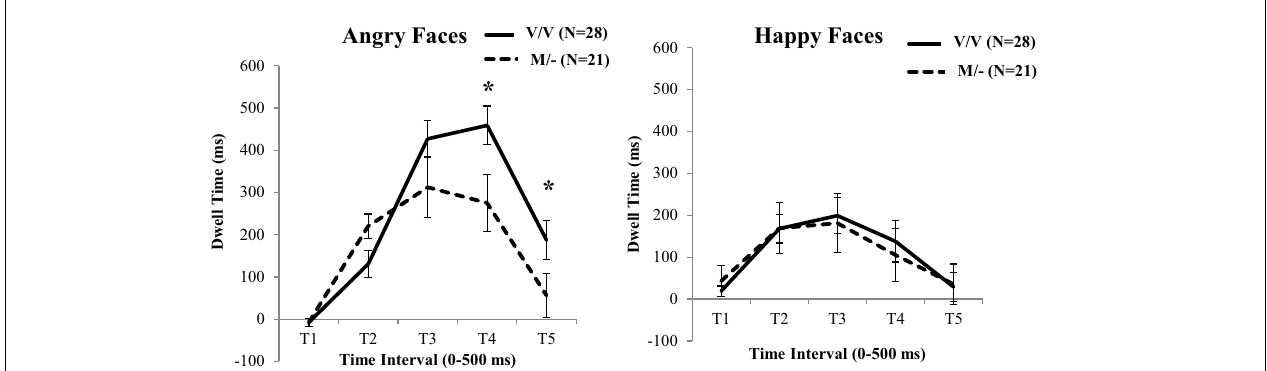
FIGURE 2 | BDNF genotype differences for fixation durations to facial expressions of Anger versus Neutral (left) and Happiness versus Neutral (right) . Carriers of at least one Met allele fixated angry face more at the early stages, but later exhibited an avoidance pattern of attention to these faces. Error bars denotes 1 SEM. * p < 0.05.